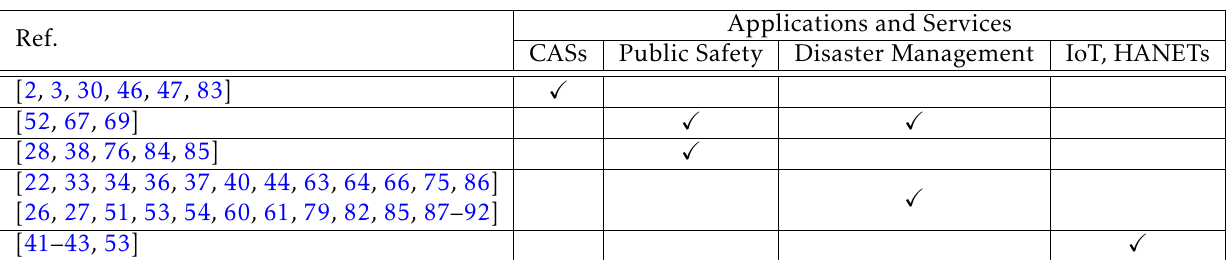
Table 3. D2D MHMP Communications Applications and Services